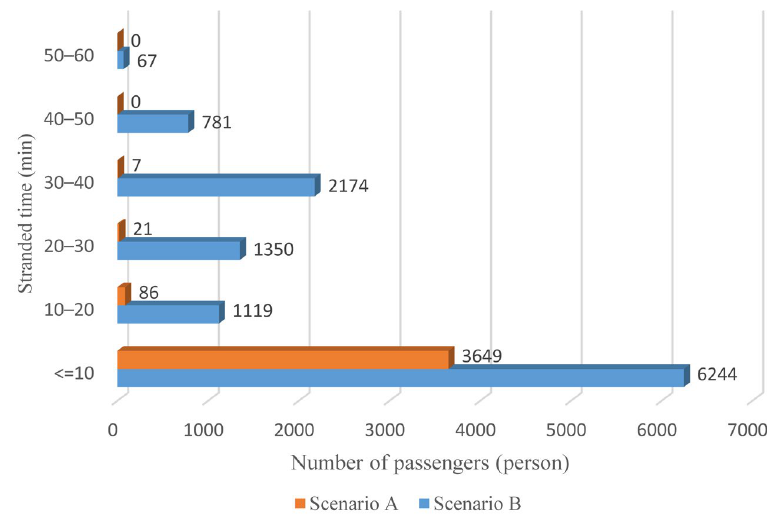
Figure 12. Stranded time distribution of affected rail passengers.